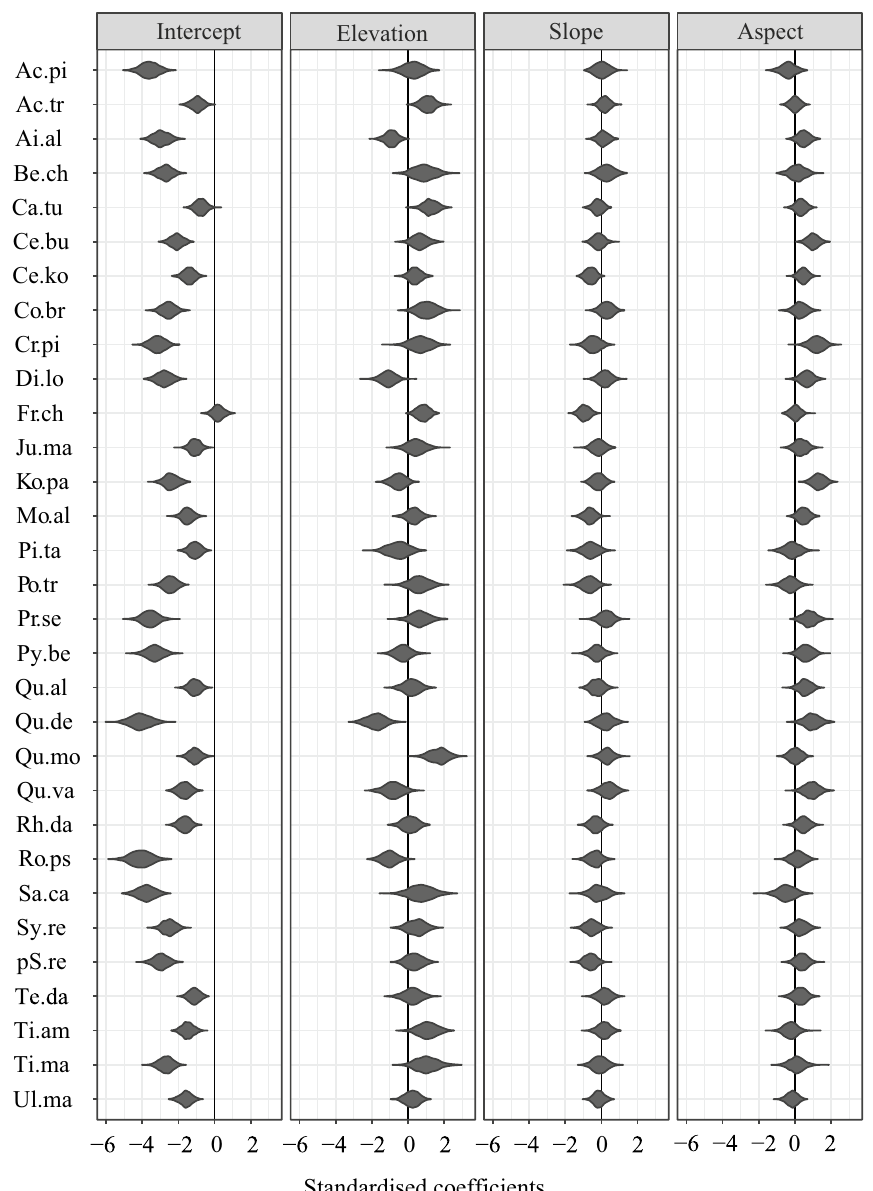
Figure 2. Estimates of fixed effects of environmental variables on 31 species occurrences given their traits. The violins refer to the uncertainty in intercepts and coefficients. Species names were shortened following Supplementary Table S1